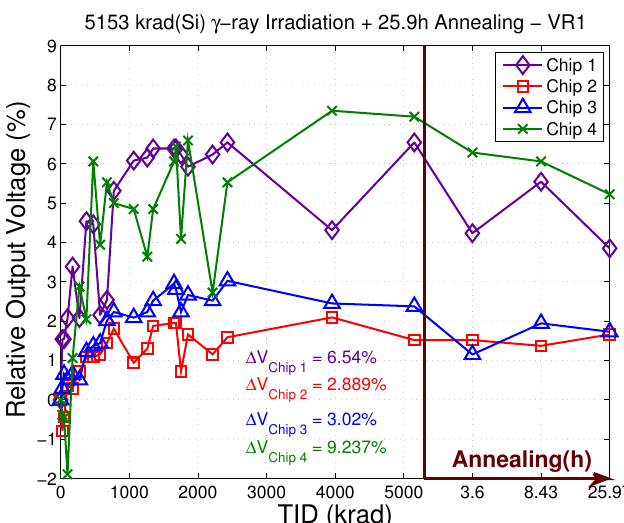
Figure 12. Relative output voltage (%) of the reference voltage (VR)1 when exposed to γ -rays at a dose rate of 25